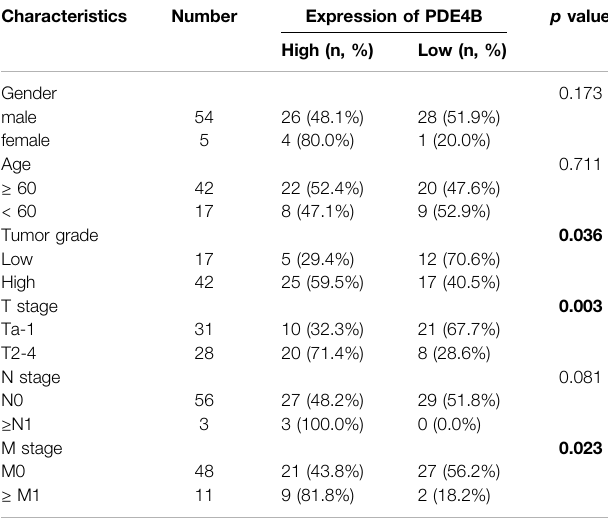
Numbers in bold indicate p value with statistical signi fi